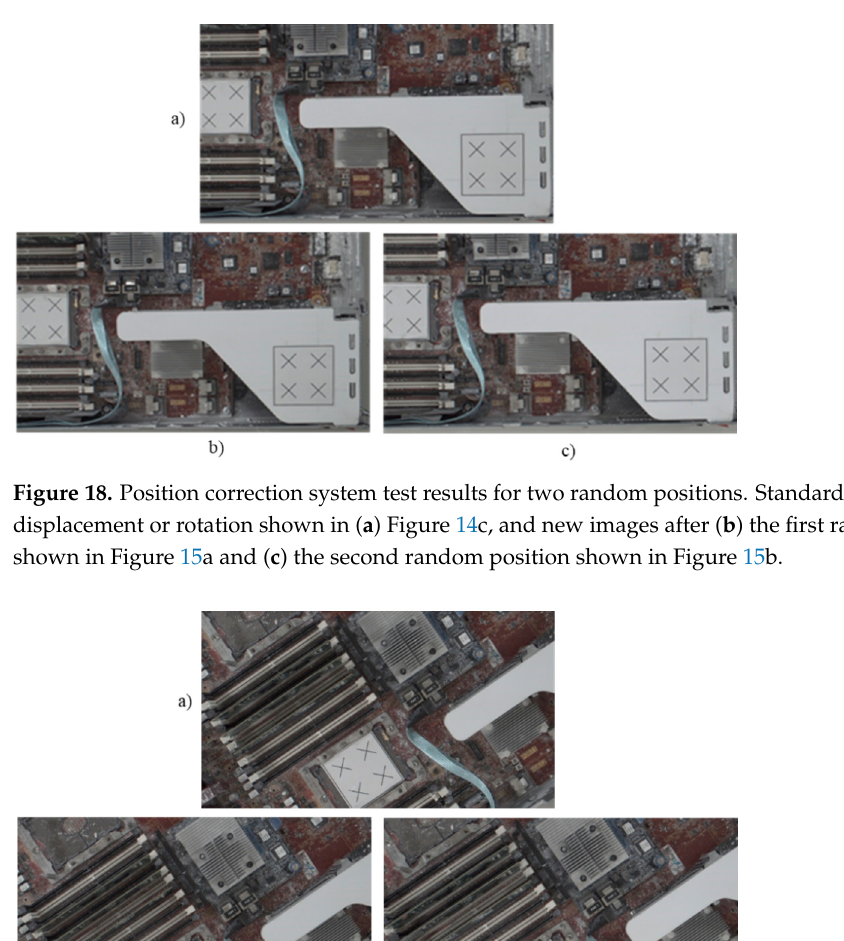
Figure 17. Position correction system test results for two random positions. Standard image without displacement or rotation corresponding to ( a ) Figure 14b, and new images after ( b ) the first random position shown in Figure 15a and ( c ) the second random position shown in Figure 15b.